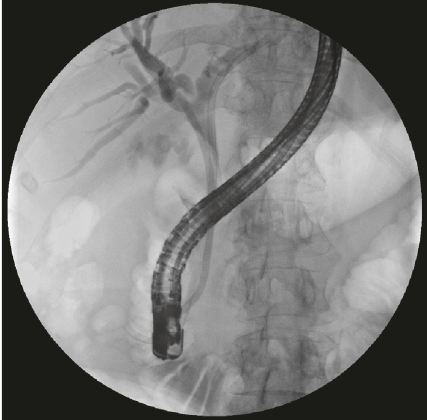
Figure 4: The same case after insertion of 2 stents.